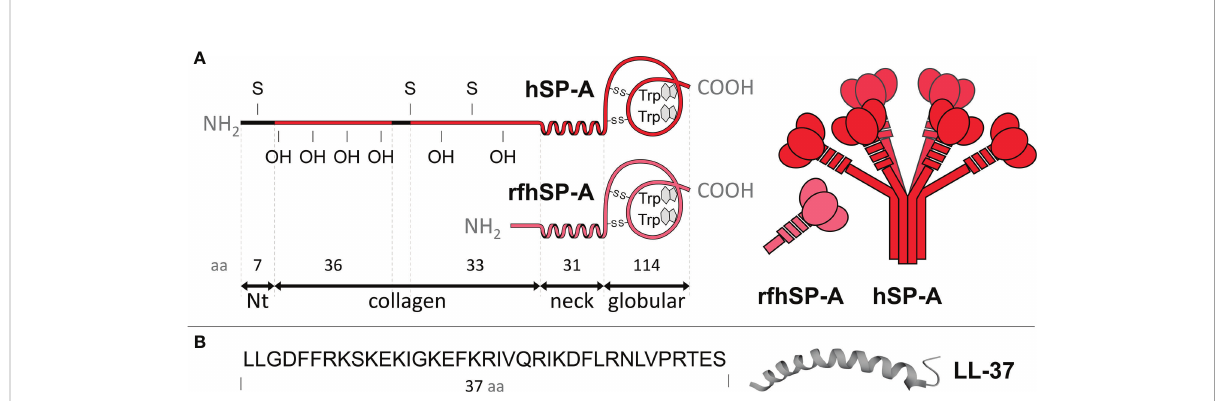
FIGURE 1 (A) The left panel shows the polypeptide chain domains of human SP-A and its recombinant fragment (rfhSP-A). S, denotes cysteine and OH hydroxyproline residues. The neck domain, between the collagen and globular domain, forms an a -helix structure involved in trimerization. The number of amino acids covering each domain is shown. The right panel shows schematic models of SP-A oligomers and rfhSP-A trimers. Each SP-A trimer is formed by the association of three polypeptide chains, whose collagen regions intertwine to form a collagen triple helix and the neck domains interlace to form an a -helical coiled-coil structure. A total of six trimers associate to form the characteristic “ bunch of fl owers ” structure of SP-A. (B) Primary sequence of LL-37 and scheme of its a helix structure. The molecules are not drawn to